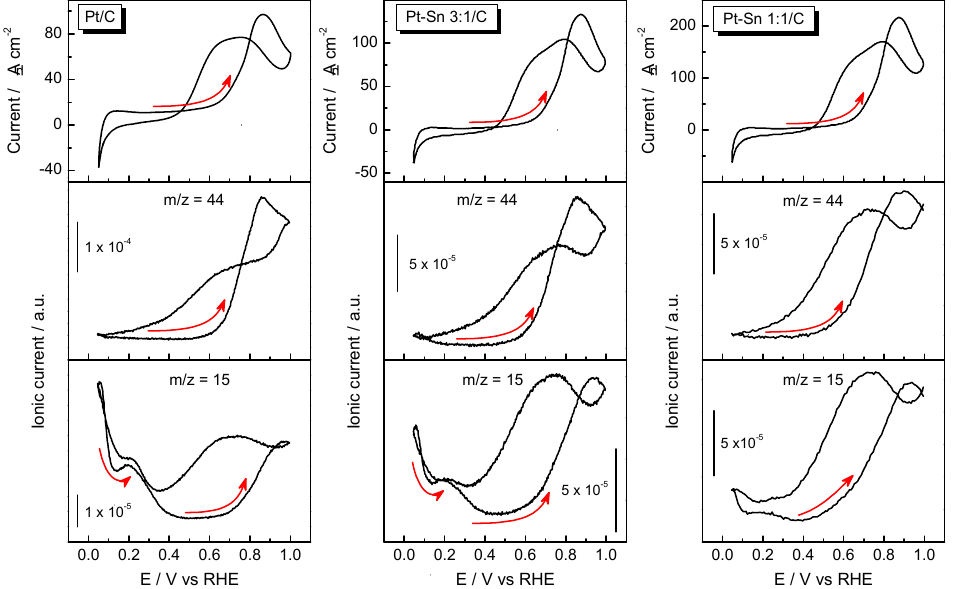
Figure 4. Ethanol electrooxidation on Pt/C, Pt–Sn 3:1/C and Pt–Sn 1:1/C catalysts in 1 M CH 3 CH 2 OH + 0.5 M H 2 SO 4 recorded at room temperature and 0.005 V·s − 1 . CVs ( top panel ) and MCVs for m / z = 44 ( middle panel ) and m / z = 15 ( bottom panel ).